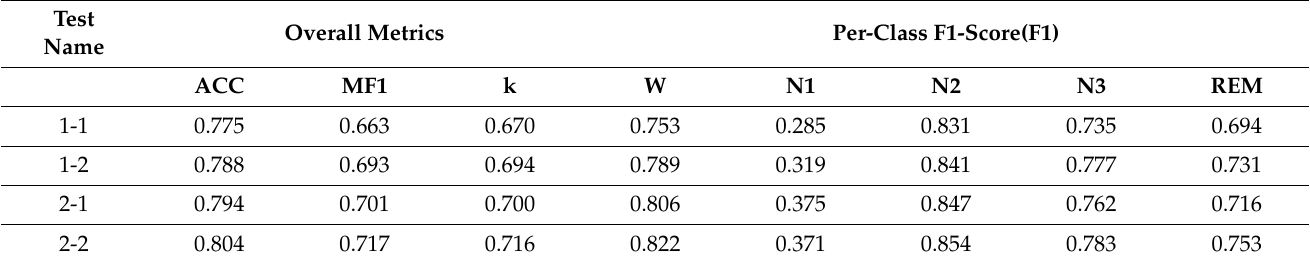
Table 3. Classification performance of training with real data and augmented